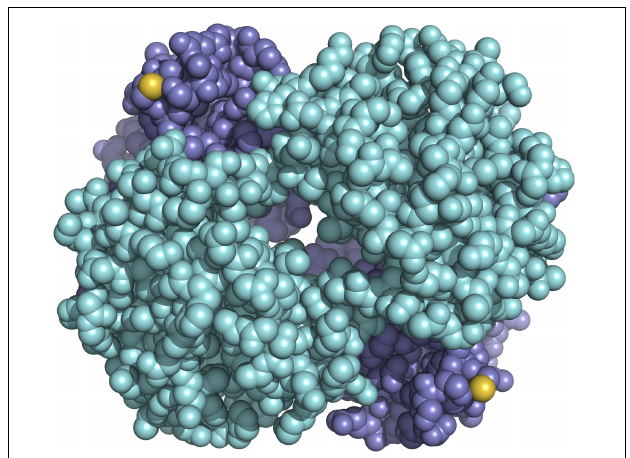
FIGURE 5 | Model of hemoglobin HbF of the bank vole showing the positions of the reactive cysteines (sulfur atoms in yellow) on the surface of the molecule, which consists of the two subunits alpha (cyan) and the two subunits beta